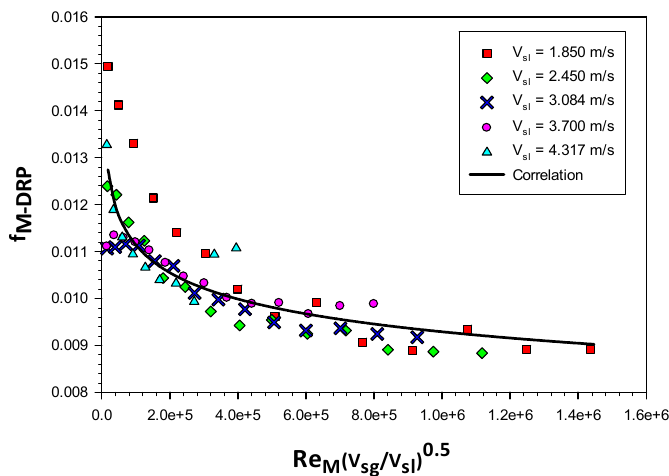
Re M(Vsg/Vsl)0.5 Figure 16. Friction factor variation with the mixture Reynolds number times the square root of the superficial velocities ratio for different liquid superficial velocities (1.85, 2.45, 3.08, 3.7 and 4.32 m/s) .